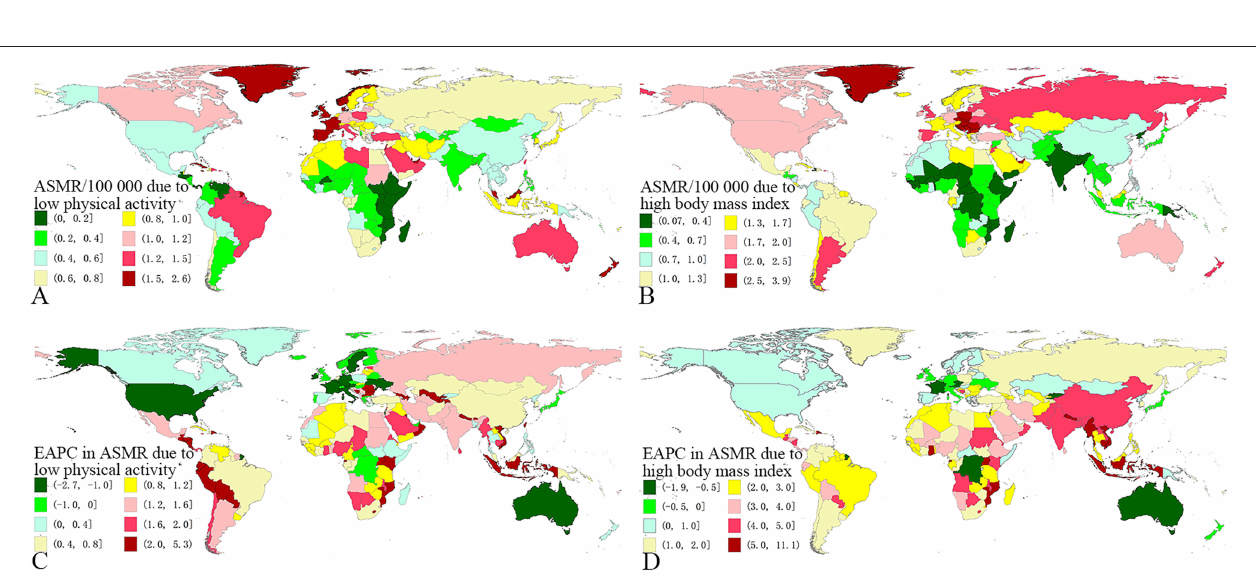
FIGURE 2 | The global distribution of colorectal cancer due to low physical activity and high BMI. (A) the ASMR of colorectal cancer due to low physical activity in 2019; (B) the ASMR of colorectal cancer due to high BMI in 2019; (C) the EAPC of colorectal cancer ASMR due to low physical activity, 1990-2019; (D) the EAPC of colorectal cancer ASMR due to high BMI, 1990–2019. ASMR, age-standardized mortality rate; EAPC, estimated annual percentage change; BMI, body mass index.